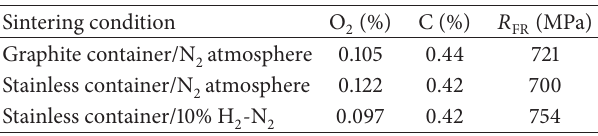
Table 8: Oxygen and carbon contents in the AstCrM + 0.5% C components sintered at 1120 ∘ C in a graphite container using N atmosphere and in a stainless container using N N 2